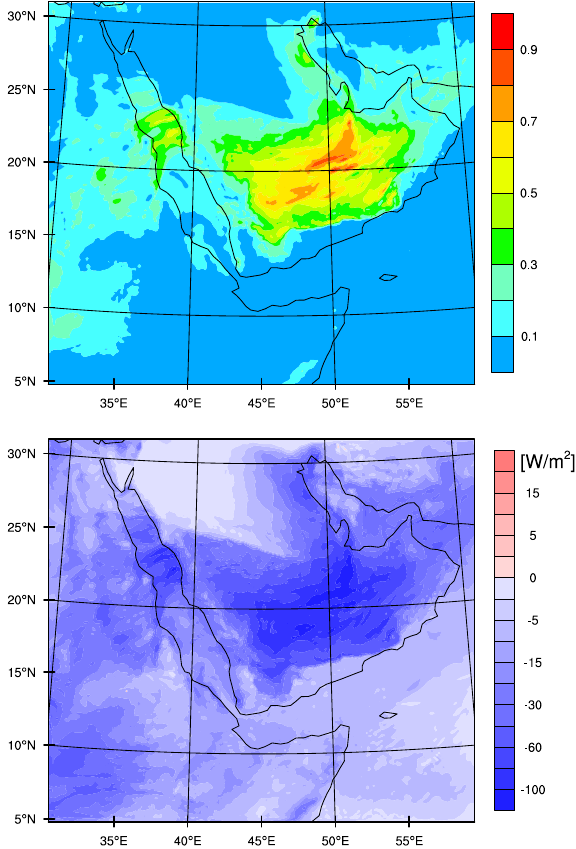
Fig. 12. The spatial distribution of AOD (top panel) and SW radia- tive forcing [Wm − 2 ] (bottom panel) at 11:00UTC on 14 January 2009.